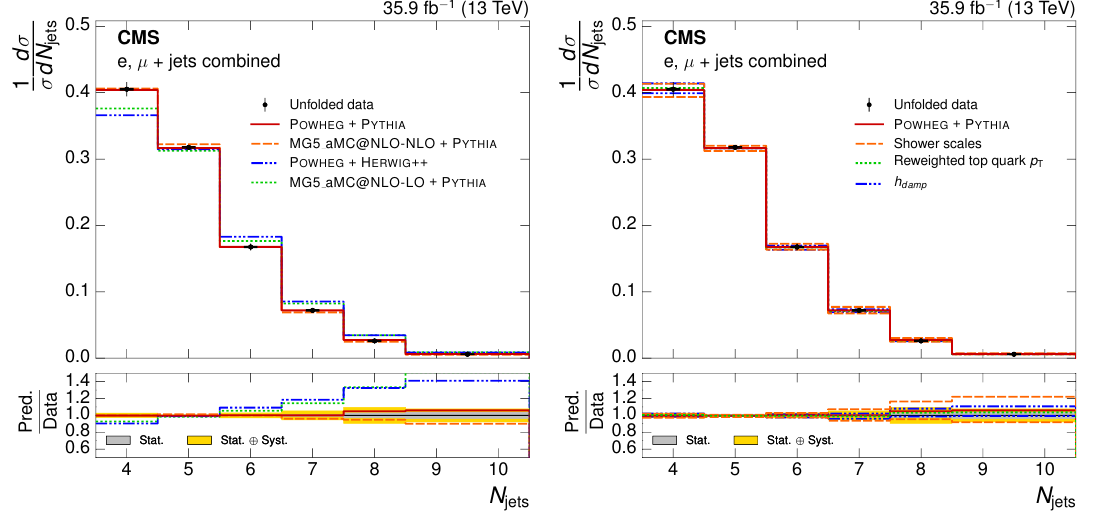
Figure 3 . Normalized N jets di(cid:11)erential tt cross section, compared to di(cid:11)erent tt simulations in the left plot, and compared to the powheg + pythia simulation after varying the shower scales, and h damp parameter, within their uncertainties, in the right plot. The vertical bars on the data represent the statistical and systematic uncertainties added in quadrature. The bottom panels show the ratio of the predictions to the